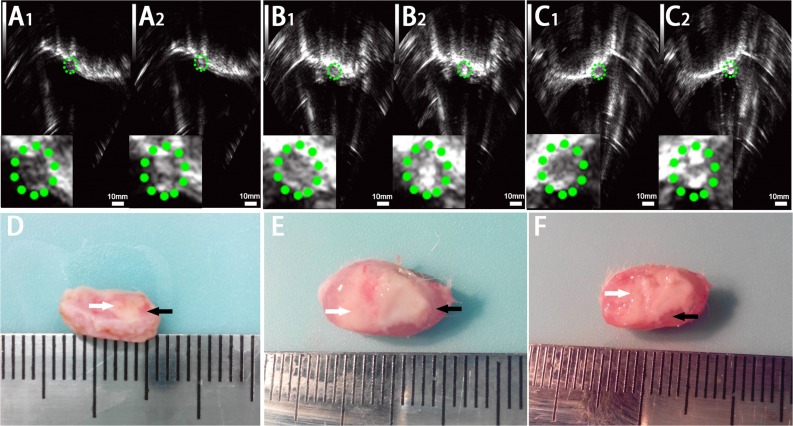
Ultrasonoscopy and photography of the targeted area in the rabbit breast tumor after HIFU ablation.Ultrasonoscopy showed echoes of the targeted area in rabbit breast tumor before (A1, B1, C1) and after (A2, B2, C2) HIFU ablation. (A) HIFU + PBS; (B) HIFU+ SonoVue MBs; (C) HIFU + lipid NBs. The green mark shows the range of tumor. (D, E, F) Photography of the targeted area in rabbit breast tumor after HIFU ablation combined with PBS, SonoVue MBs and lipid NBs, respectively. The necrotic tissue showed gray (white arrow) and non-ablated tissue appeared darkled (black arrow).